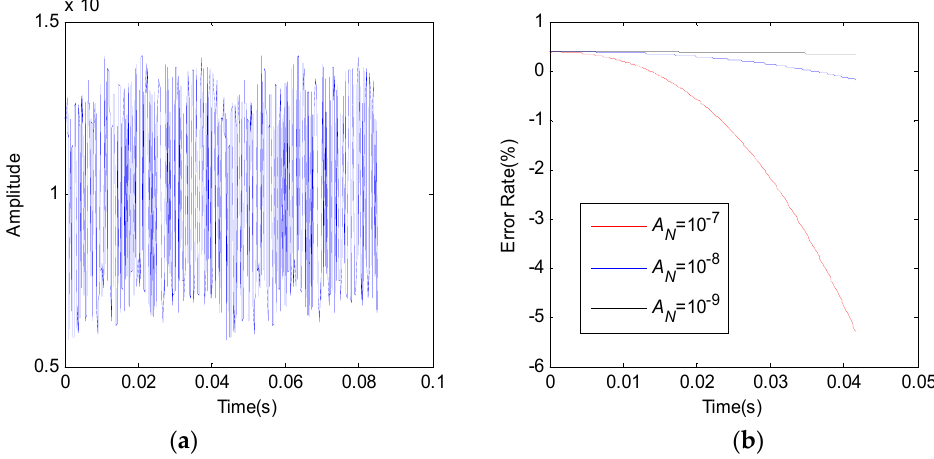
Figure 12. Suppression of direct-current (DC) interference by m-sequence. ( a ) Superposition of excitation field and DC interference; ( b ) identification error of different DC interference.